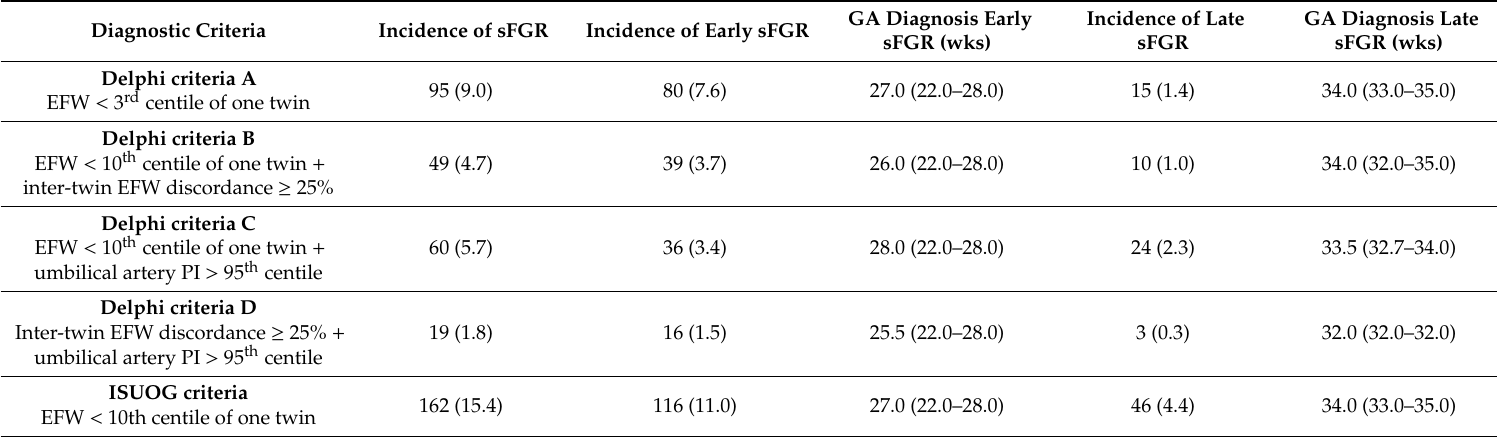
Table 2. Incidence of selective fetal growth restriction (sFGR) in dichorionic twin pregnancies according to the various proposed diagnostic criteria as stated by a consensus reached through a Delphi process (Khalil A 2019) and ISUOG twin guideline, as well the gestational age at diagnosis. Data are shown as number (%) or median